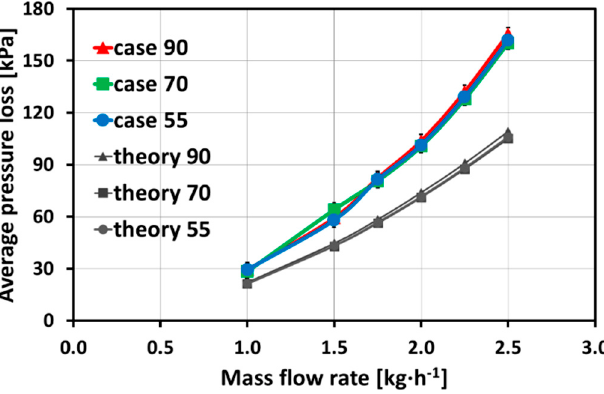
Figure 4. Average pressure loss for straight micro channels with different inlet temperatures in comparison with conventional theory (with a maximum uncertainty of Δ ( Δ p ) = ±4.0 kPa).